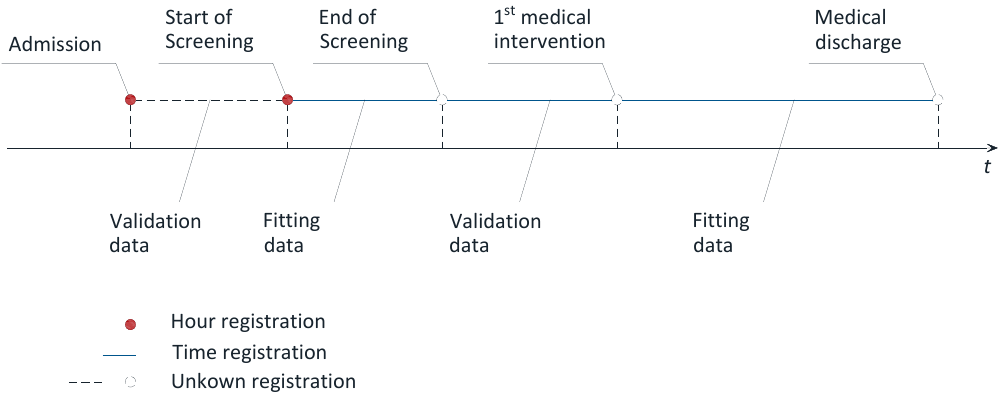
Figure 4. Patient flow schematic with the indicators, provided by the hospital, used in the present study.